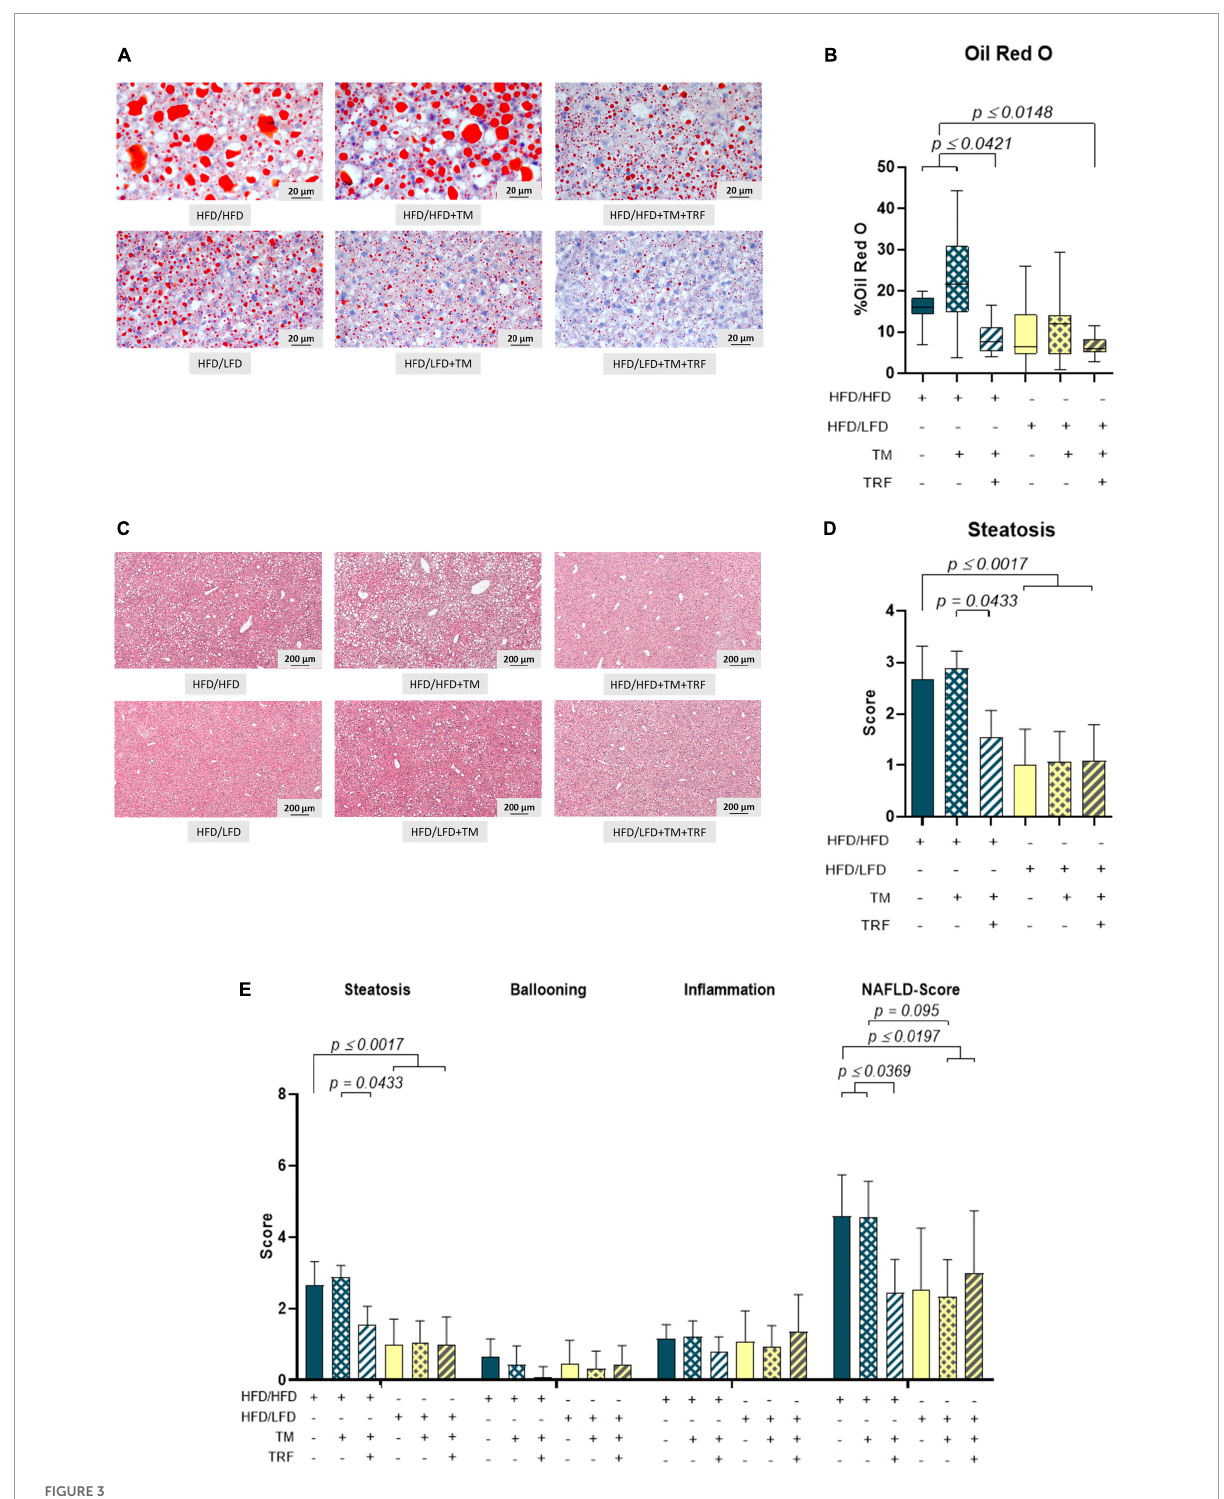
FIGURE3 Representative images of Oil Red O (A) (400 × magnification, scale bar represents 200 µ m) and HE-stained liver specimen. (C) (50 × magnification, scale bar represents 200 µ m) and quantitative analysis of the Oil Red O-stained area in percentage (B) (HFD/HFD: n = 11, HFD/HFD + TM: n = 11, HFD/HFD + TM + TRF: n = 12, HFD/LFD: n = 13, HFD/LFD + TM: n = 15, HFD/LFD + TM + TRF: n = 10; total n = 72) and steatosis score (D) (HFD/HFD: n = 12, HFD/HFD + TM: n = 9, HFD/HFD + TM + TRF: n = 11, HFD/LFD: n = 13, HFD/LFD + TM: n = 15, HFD/LFD + TM + TRF: n = 11; total n = 71). Assessments of scores for steatosis, ballooning, and inflammation, as well as calculation of NAS for